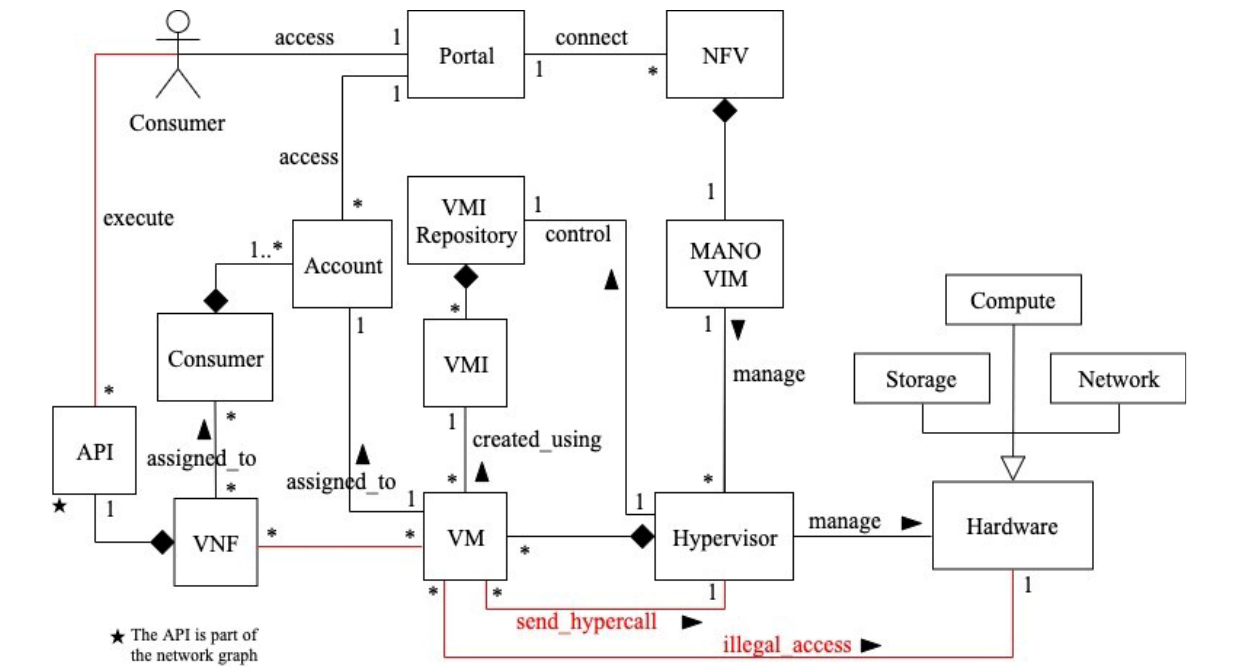
Figure 4 . Class diagram for privilege-escalation-based misuses in NFV [11] . Figure 4. Class diagram for privilege-escalation-based misuses in NFV [11].